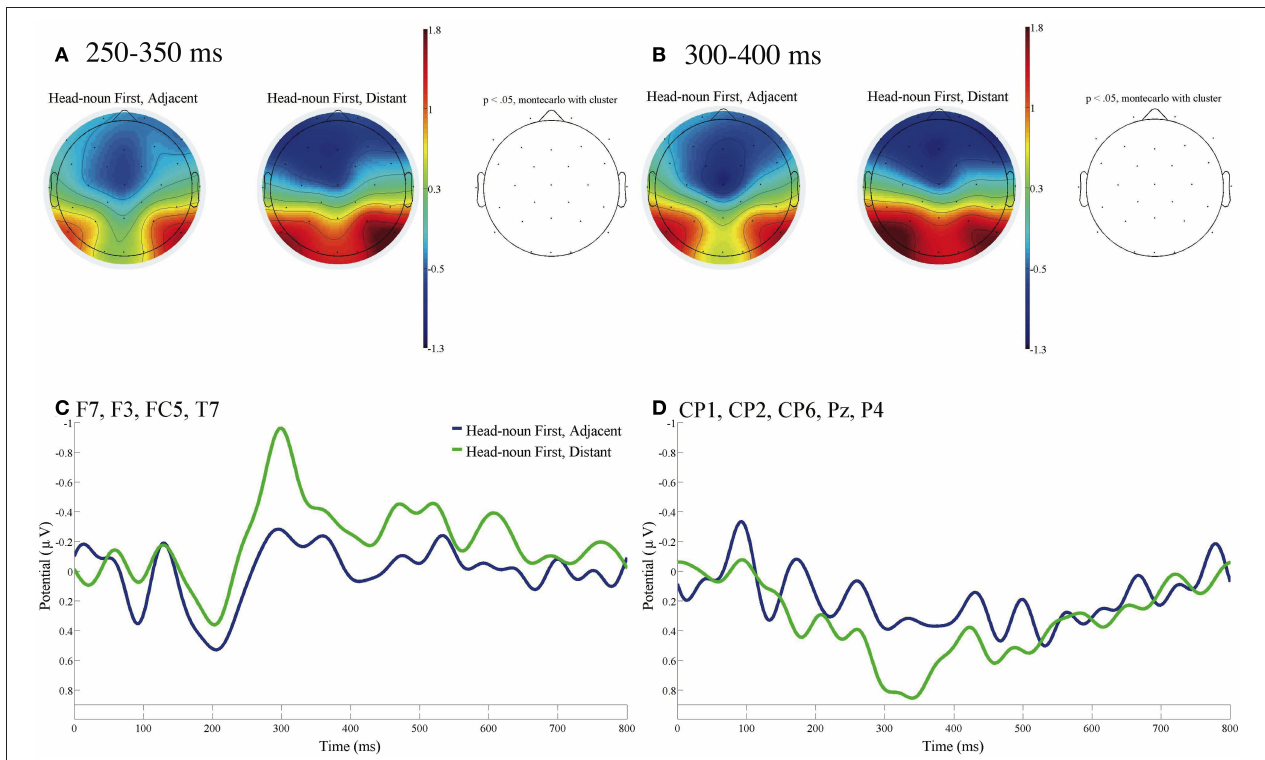
FIGURE 3 | ERPs time-locked to the onsets of the fifth phrases of Head-noun First (A–D) with the baseline from 0 to 100 ms. (A) Mean topographies of the ERPs from 250 to 350 ms and (B) those from 300 to 400 ms for Adjacent (left) and Distant (right) conditions; the electrode sites at which significant differences were found by using the cluster-based permutation test ( p < 0.05) are depicted in red. (C) Mean ERPs of the two conditions at the left frontal electrodes (F7, F3, FC5, and T7) and (D) Mean ERPs of the two conditions at the (right) parietal electrodes (CP1, CP2, CP6, Pz, and P4) in the same manner as Figure 2 . Negativity is plotted upward, and the time windows during which significant differences were found by the cluster-based permutation test are indicated in black on the time axes in (C,D)